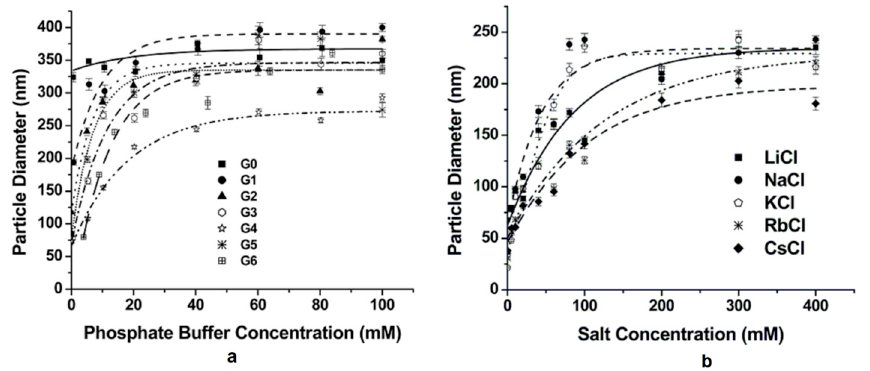
Figure 22. ( a ) Particle size of nanospheres produced by different PAMAM generations as a function of phosphate buffer concentration ( b ) as a function of salt concentration for different alkali metal chlorides (Reproduced with permission from [143]; Copyright American Chemical Society, 2005).